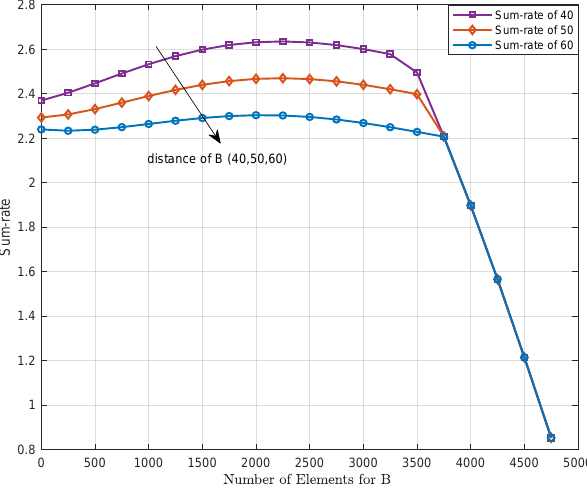
Figure 3. The sum-rate of the system versus the reflecting elements number with a fixed A.